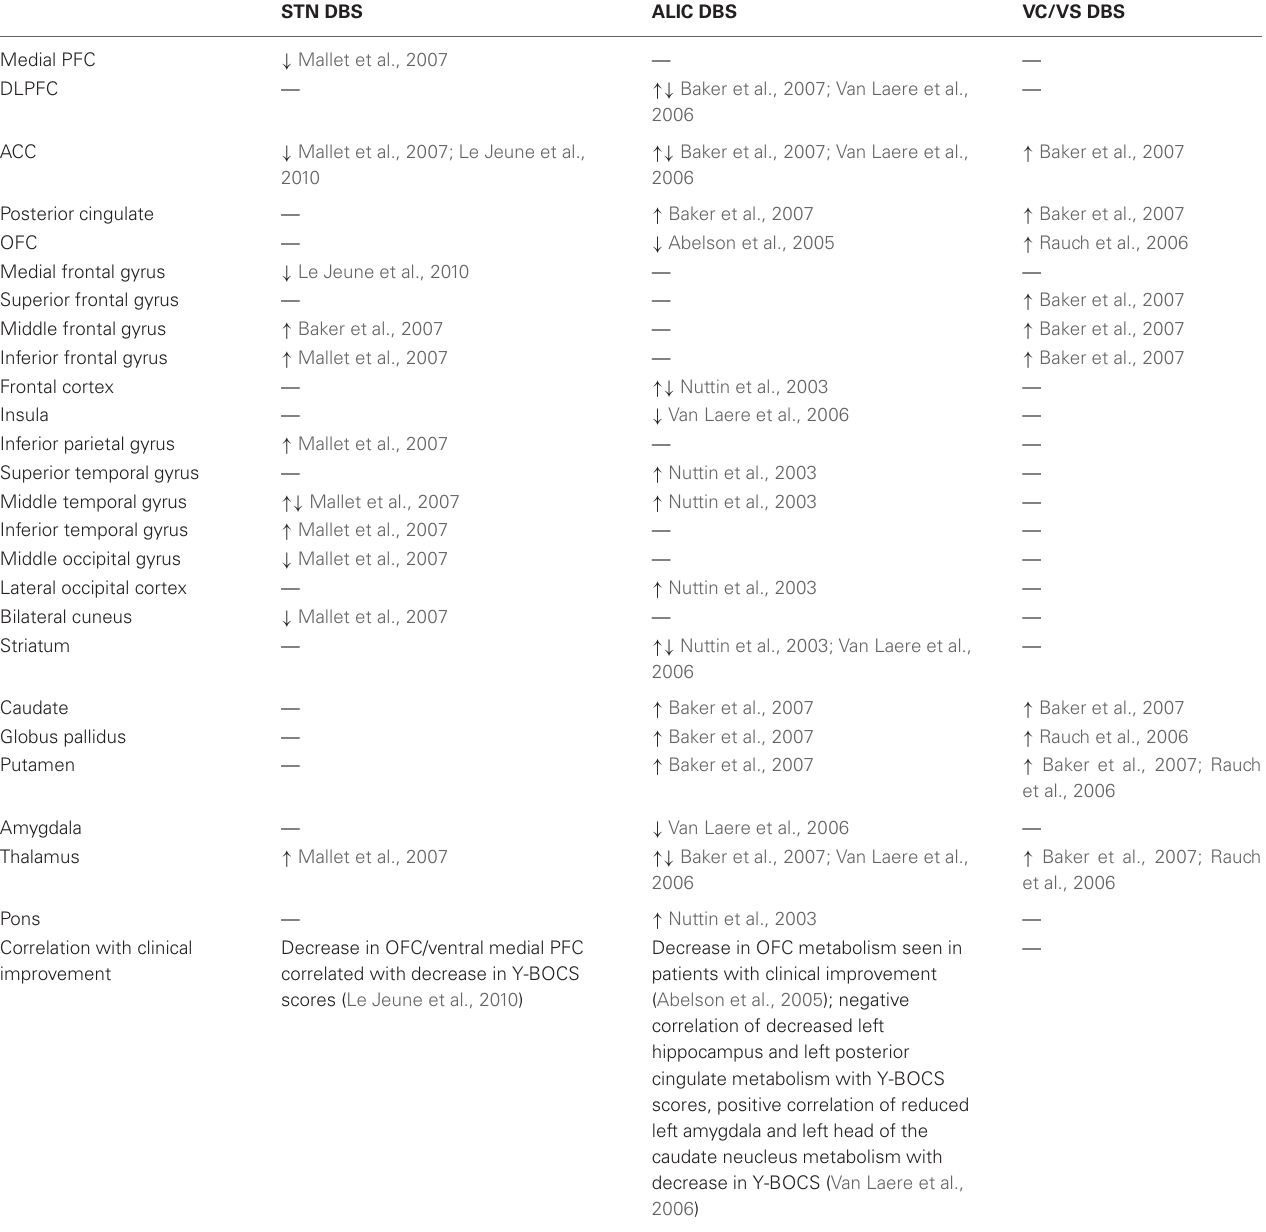
Table 2 | Findings of functional imaging studies during stimulation of DBS targets used for